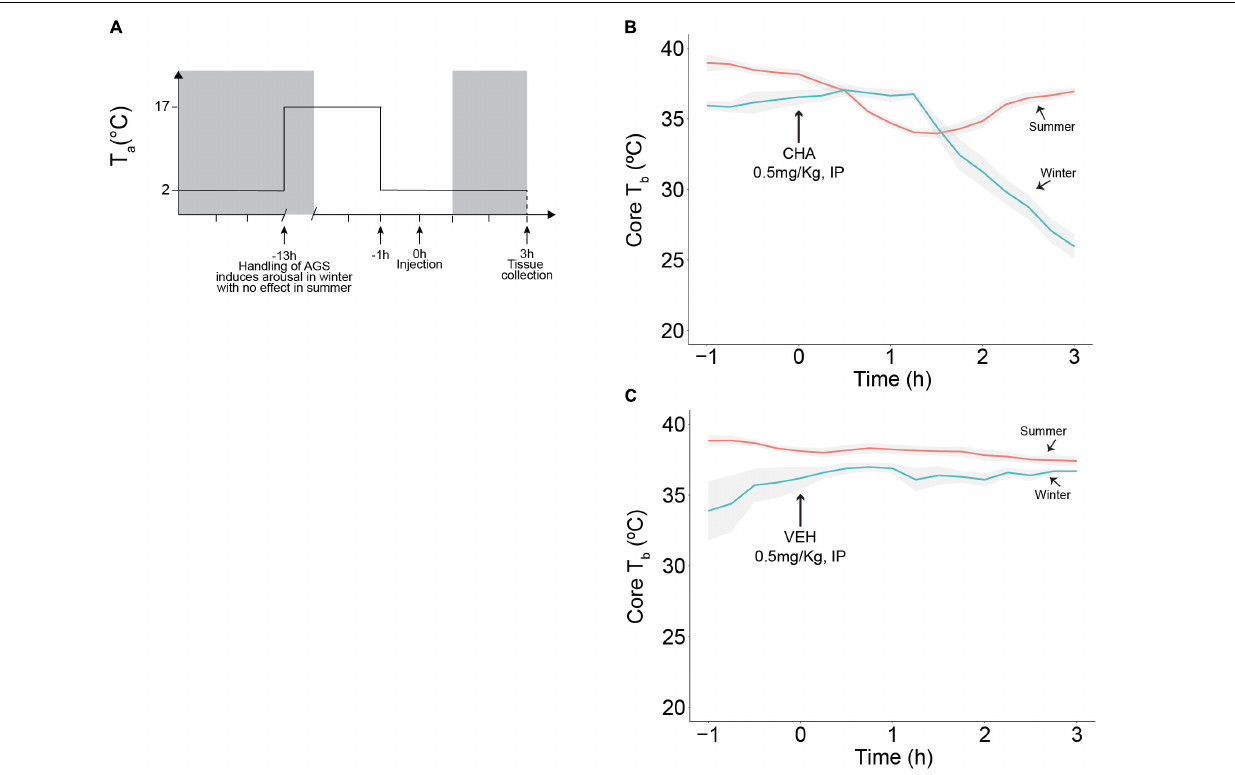
FIGURE 2 | CHA, adenosine A 1 receptor agonist, promotes onset of hibernation in a seasonally dependent manner. Experimental design is illustrated in (A) , treatment (CHA or VEH) was administered at time 0 and tissue collection was performed 3 h after injection, 2 h into the dark cycle (dark cycle is represented by gray area). CHA promotes the onset of hibernation in Winter AGS. Summer AGS respond to CHA briefly and restore the initial T b value (B) . Vehicle does not affect T b (C) . Data shown as mean ± SEM, n = 4–7. Arrow at 0 h indicates time of injection.